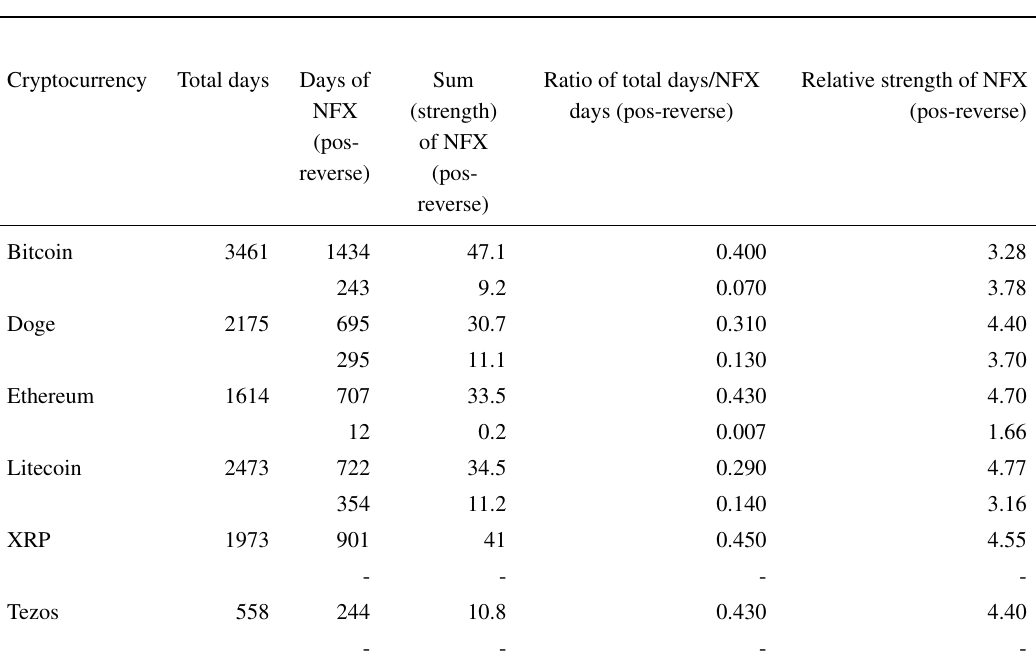
Table 4. Network effects measurements based on the Token price - Addresses with non zero balance proxy pair